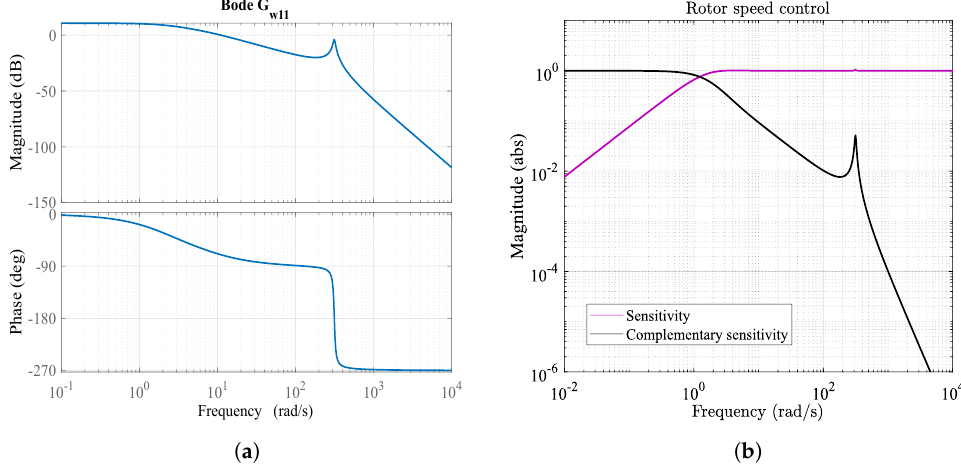
Figure 7. Open-loop and closed-loop frequency response of the rotor speed. ( a ) Frequency response of G w11 ( s ) ; ( b ) closed-loop response of the plant G w11 ( s ) . HST Pressure Control: The HST pressure, p t , is controlled by the HST motor